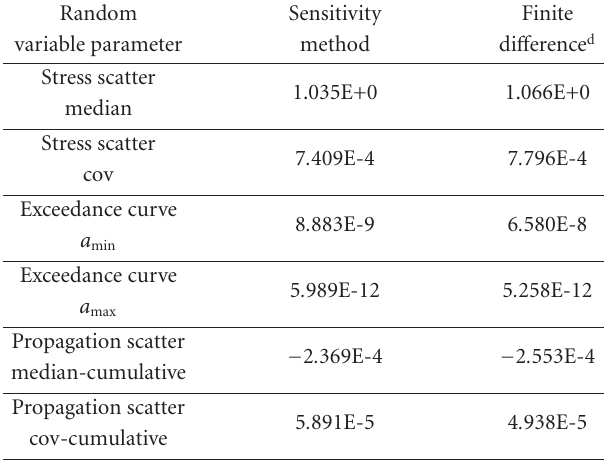
Table 5: Comparison of disk POF sensitivity equations with finite di ff erence